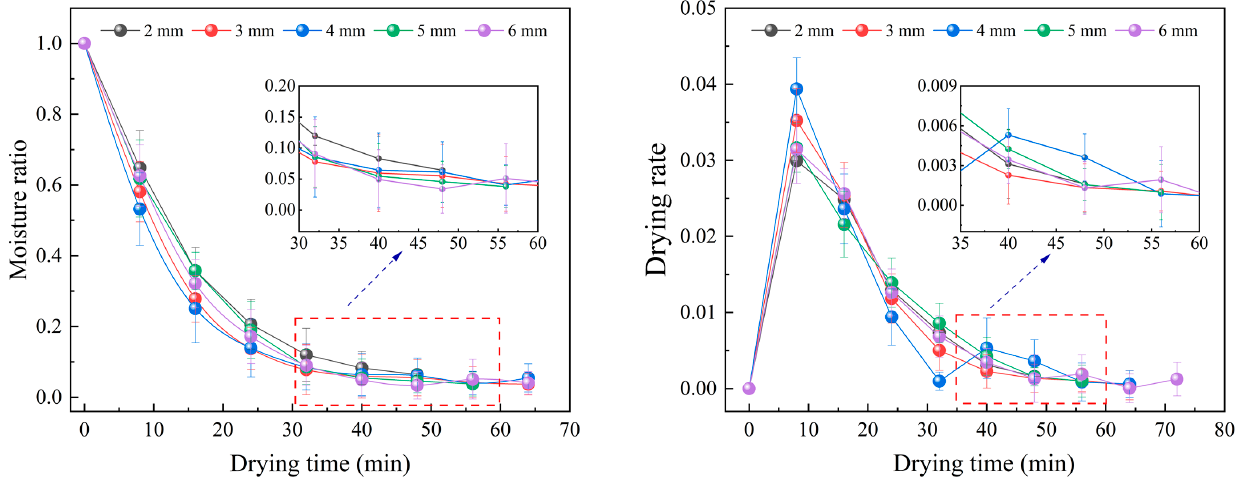
Figure 3. Effects of slice thickness on drying curve and drying rate curve.